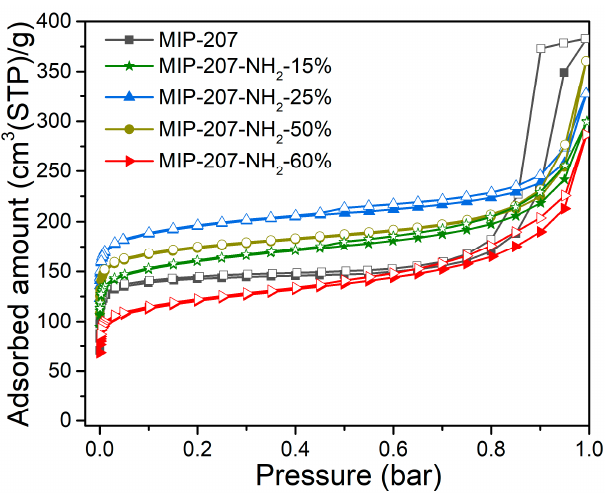
Figure 3. N 2 adsorption and desorption isotherms at − 196 °C.